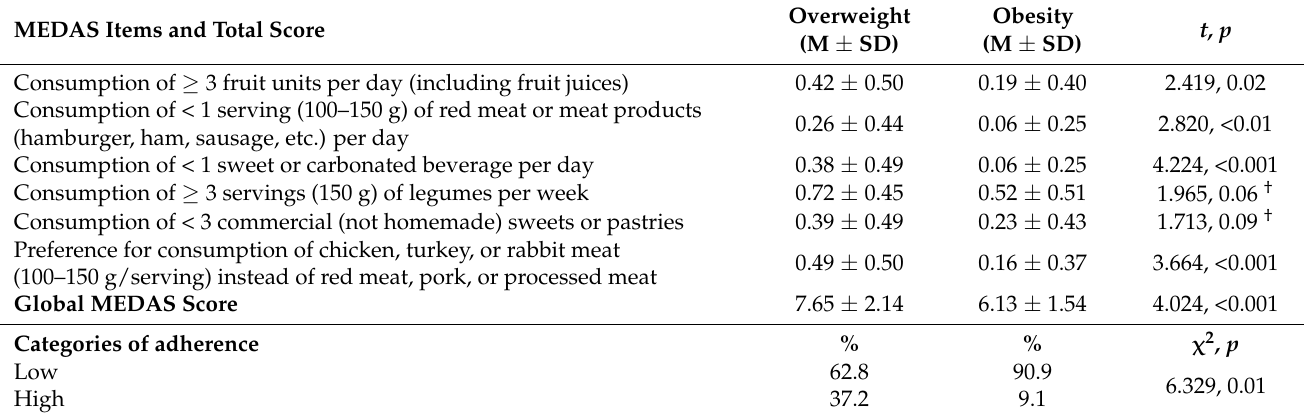
Table 3. Significant differences in diet indicators between participants with overweight and